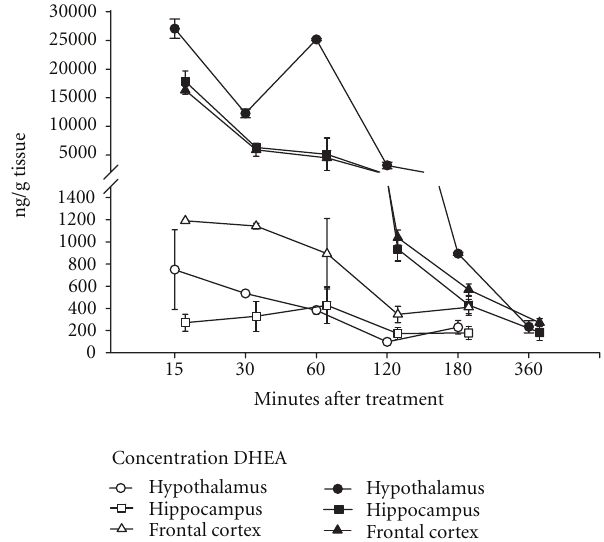
Figure 1: The amount of DHEA (ng/g) present in the hypotha- lamus, hippocampus, and frontal cortex of rats over a six-hour time period after a single acute intraperitoneal injection. Adult male Long-Evans rats received either 56 mg/kg of DHEA ( n = 6) or an equal volume of cyclodextrin vehicle ( n = 5). A DHEA- treated subject was sacrificed with a vehicle-treated control at 15, 30, 60, 120, and 180 minutes after injection, while the final DHEA- treated subject was sacrificed 360 minutes after injection. Brains were collected, flash frozen, and later dissected using the Glowinski technique [75]. Steroids were extracted from the hypothalamus, hippocampus, and frontal cortex of each subject using the solid- phase extraction method described and validated by Newman et al. [74]. Briefly, tissue from each region was prepared in an aqueous matrix and steroids were extracted from each sample using a C18 column primed with ethanol and equilibrated with water. Each sample was eluted, dried, and resuspended in deionized water, and DHEA levels were determined using